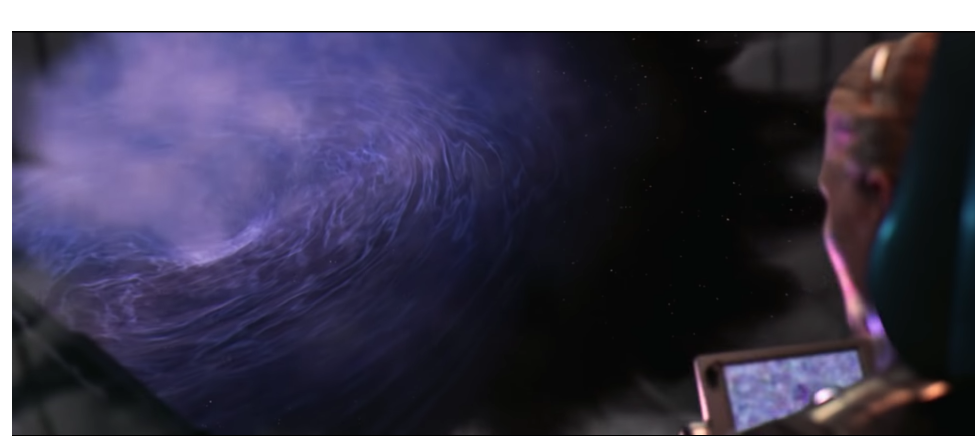
Figure 3: Contact . Ellie takes a leap of